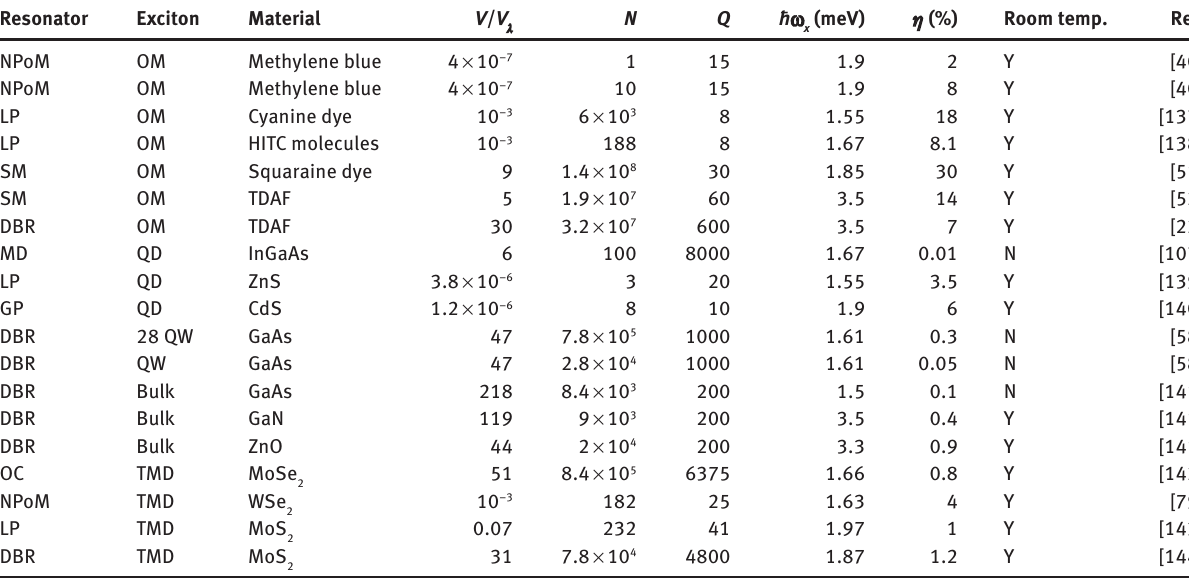
Table 2: Estimated figures of merit for representative exciton–polariton systems, from dielectric DBR microcavities to plasmonic arrays and localised plasmonic cavities. Resonator